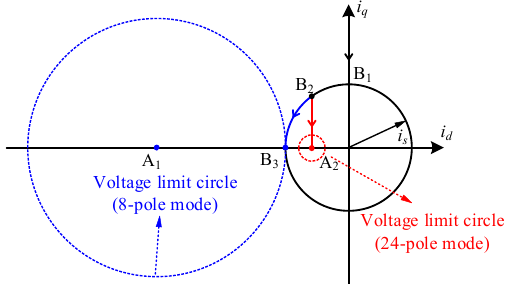
Figure 8. The operation characteristics of DHPCM-SPMPs.